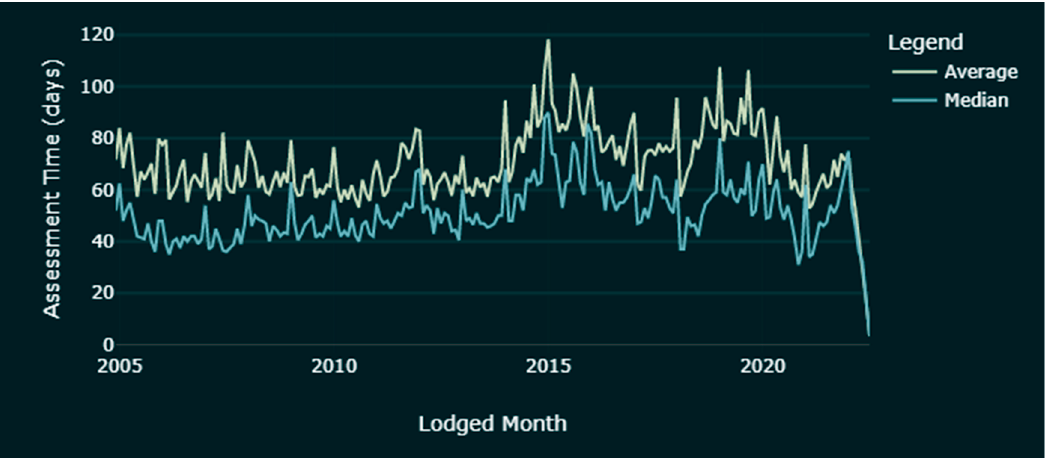
Figure 40. Average and median assessment time for all determined DAs by month (2004–2022).